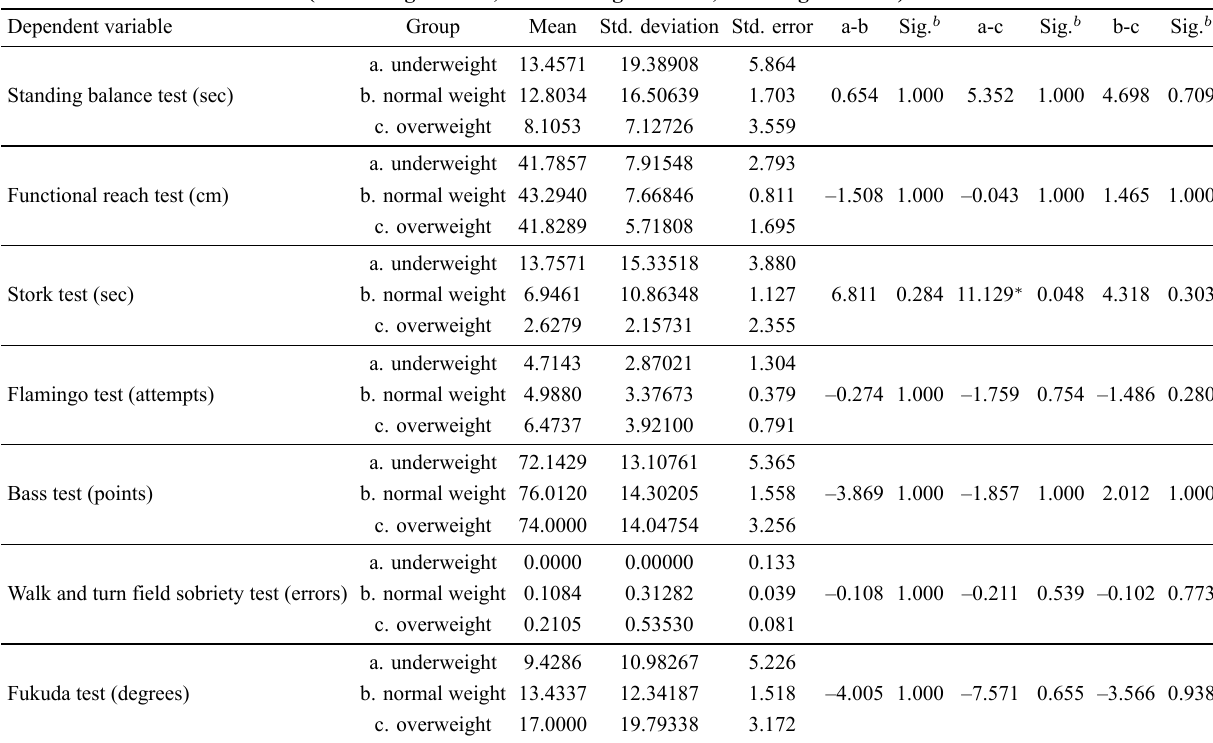
Table 4. Average values of the scores obtained by the groups (BMI classes) and the significance of the difference between them (underweight/N = 7, normal weight/N = 83, overweight/N =